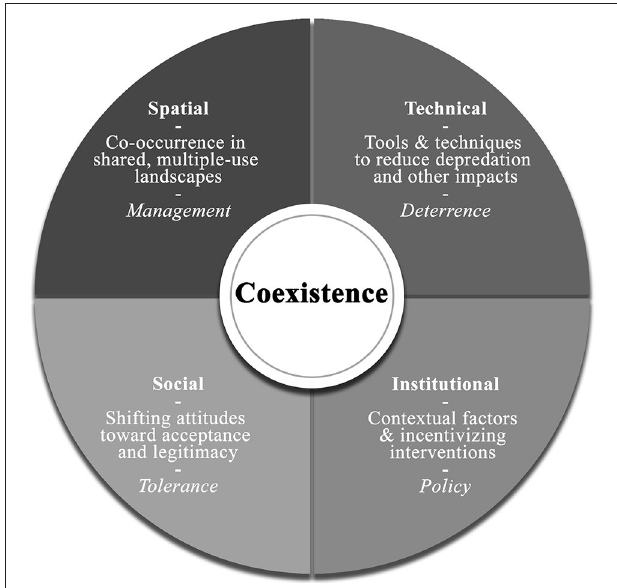
FIGURE 3 | Dimensions of